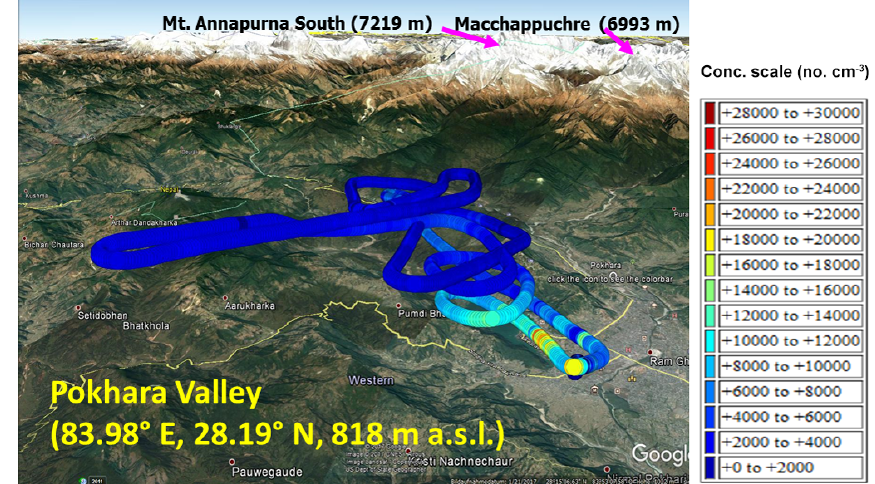
Figure 1. A typical test flight within the Pokhara Valley on 5 May 2016. The plot is generated using a Matlab–Google Earth toolbox (https://www.mathworks.com/matlabcentral/fileexchange/12954-google-earth-toolbox, last access: 3 March 2017, ©Scott L. Davis). Each dot is a single sample point (sampling frequency of 1Hz); the color of the dot indicates the total aerosol number concentration and the value of each color is shown as a color